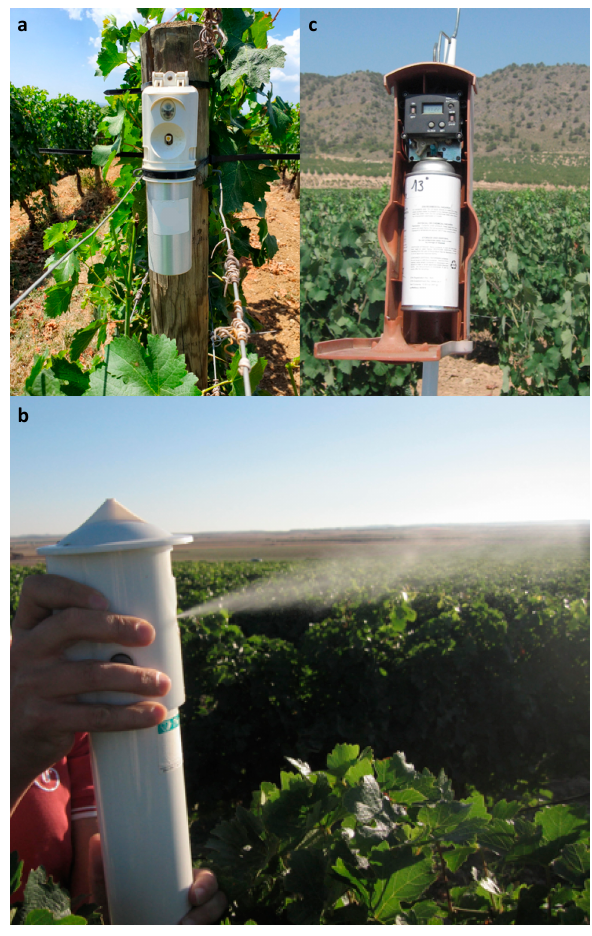
Figure 3. Aerosol devices used for pheromone-mediated mating disruption of the European grapevine moth, Lobesia botrana , on grapevine: (a) Isonet® MISTER PRO L, (b) Isonet® MISTER releasing a puff of L . botrana pheromone in a Spanish vineyard, (c) CheckMate® Puffer® LB (Suterra) (photo credit: Andrea Lucchi).